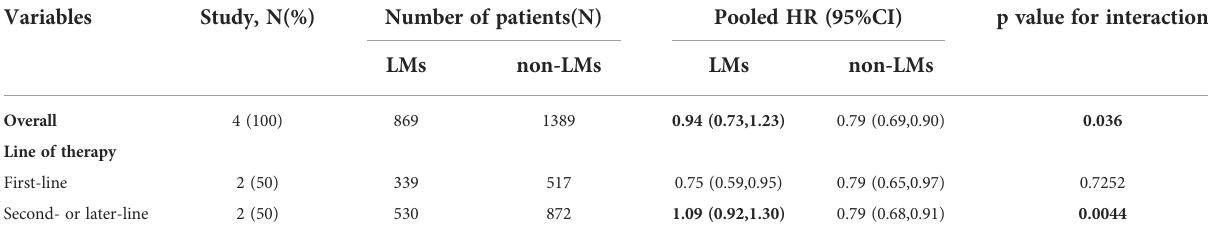
TABLE 3 Analyses of SCLC pooled hazard ratios for OS outcomes by